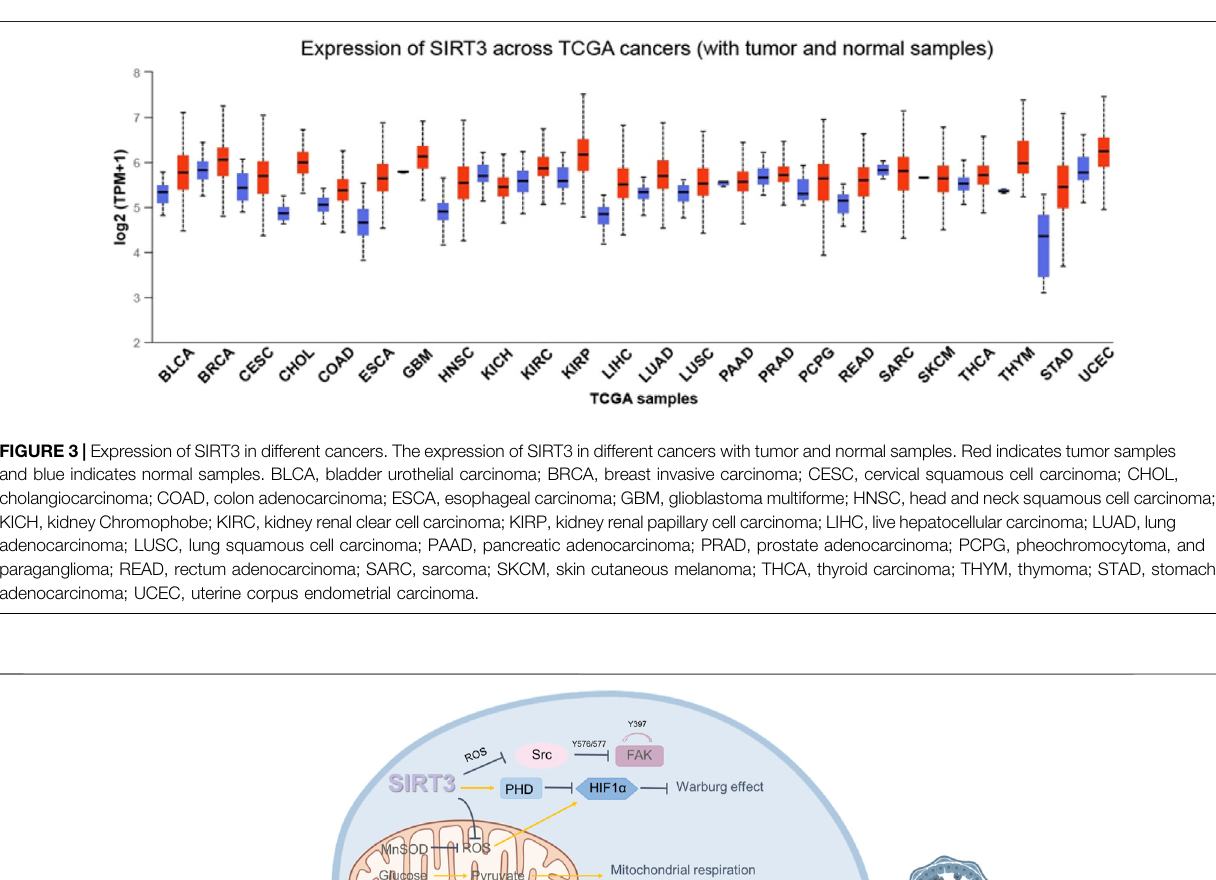
Frontiers in Pharmacology |